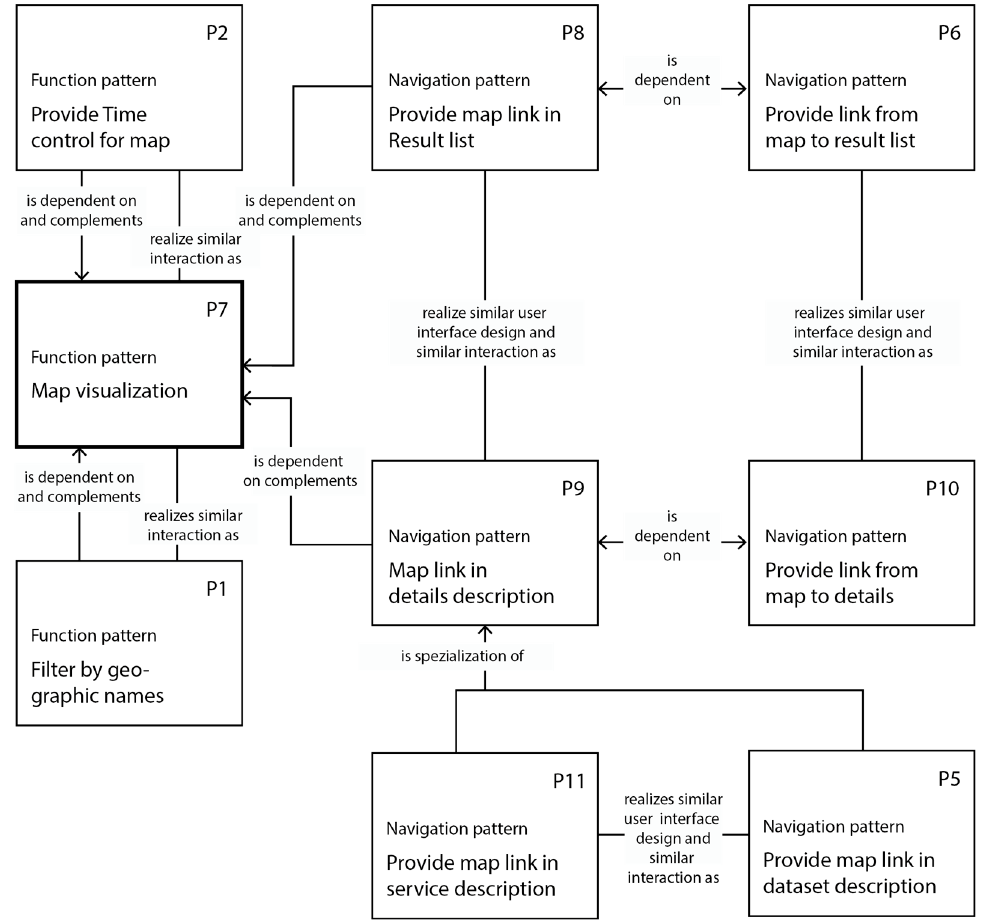
Figure 3. Eight usability patterns for GI web applications and their